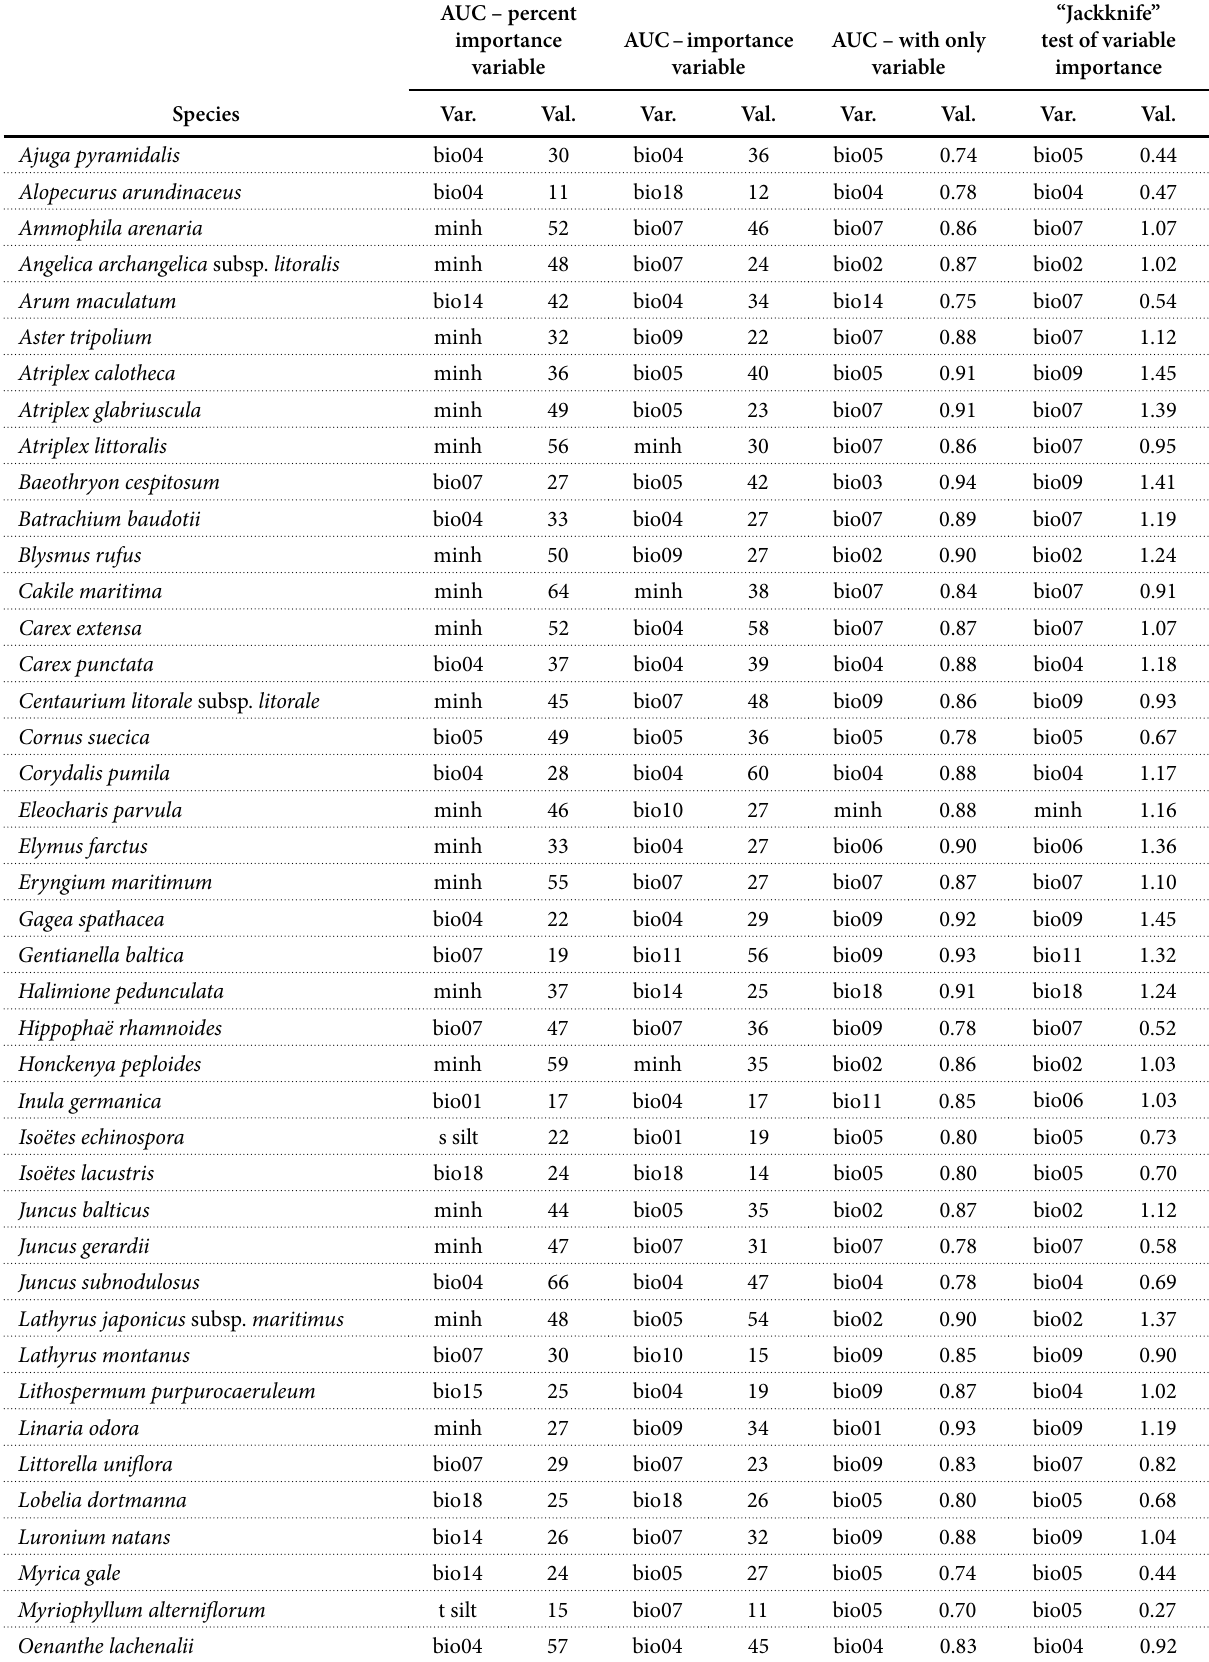
Tab. 3 Vascular plant species characterizing Pomerania: results AUC and jackknife test with high value of importance variable. For description of variables see Appendix